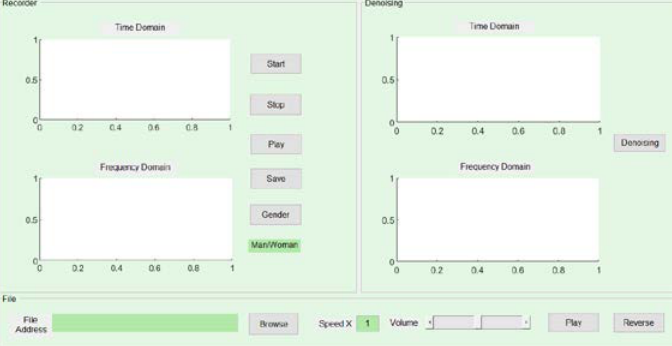
Fig. 3. Integrated audio processor